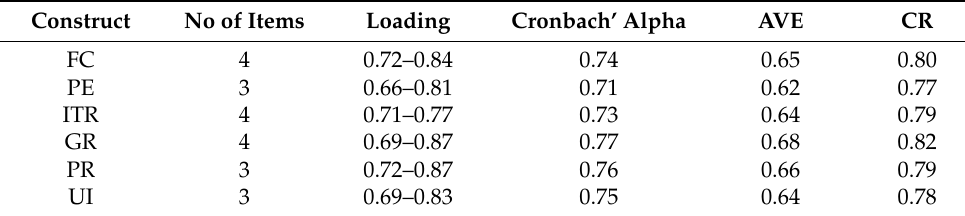
Table 2. Construct Reliability.